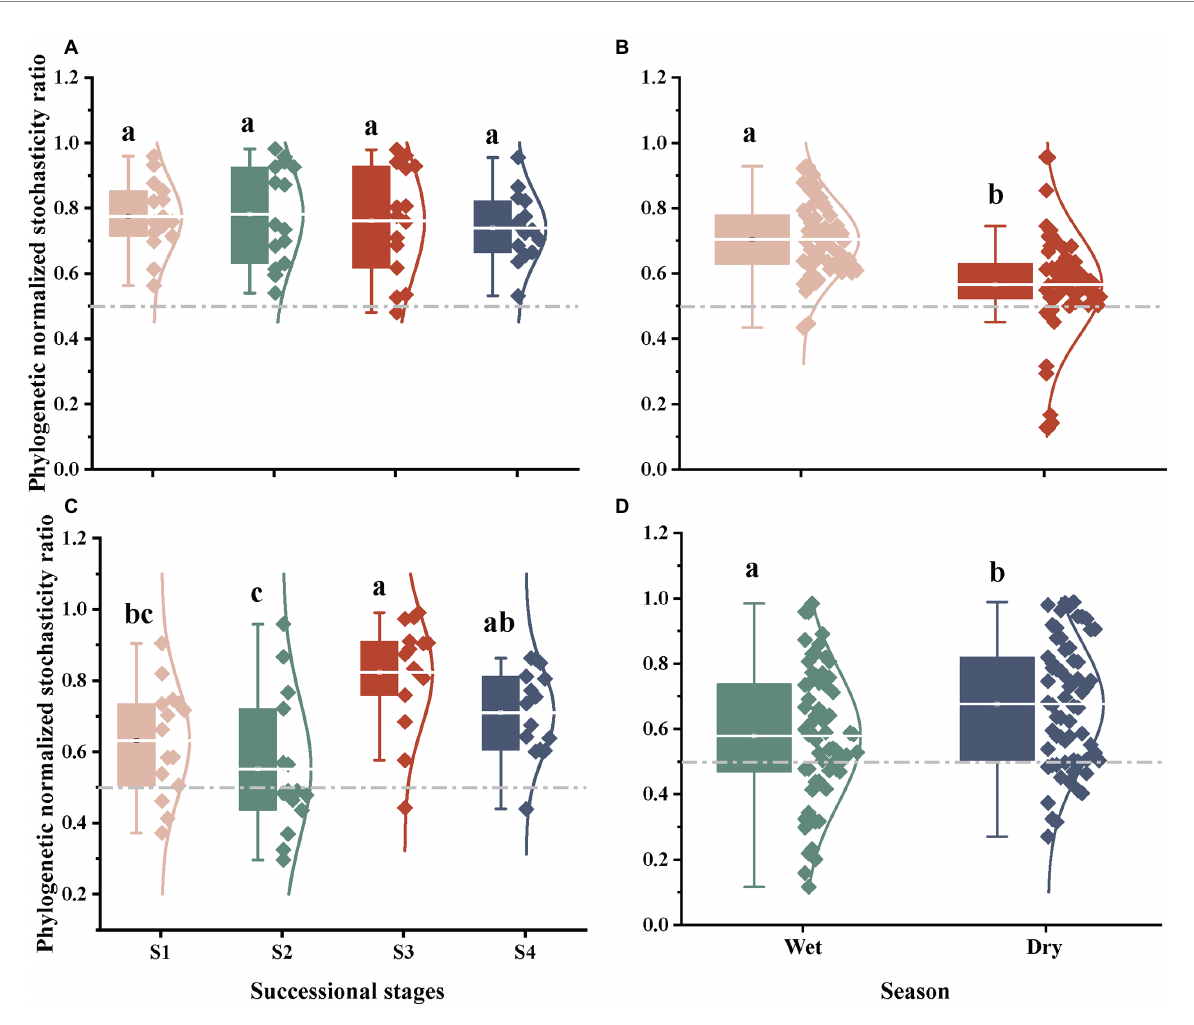
FIGURE 4 The ecological stochasticity in the potentially bacterial (A,B) and fungal (C,D) community assembly estimated by the phylogenetic normalized stochasticity ratio (pNST). (A) , ecological stochasticity of soil bacteria among different stages of forest succession; (B) , ecological stochasticity of soil bacteria between different seasons. (C) , ecological stochasticity of soil fungi among different stages of forest succession; (D) , ecological stochasticity of soil fungi between different seasons. The value of 0.5 as the boundary point between more deterministic (<0.5) and more stochastic (>0.5) assembly. S1, initial stage; S2, early stage; S3, middle stage; S4, late stage. Different lowercase letters indicate significant differences in different stages of forest succession (or different season) ( p < 0.05). Differences between dry and wet seasons were examined using